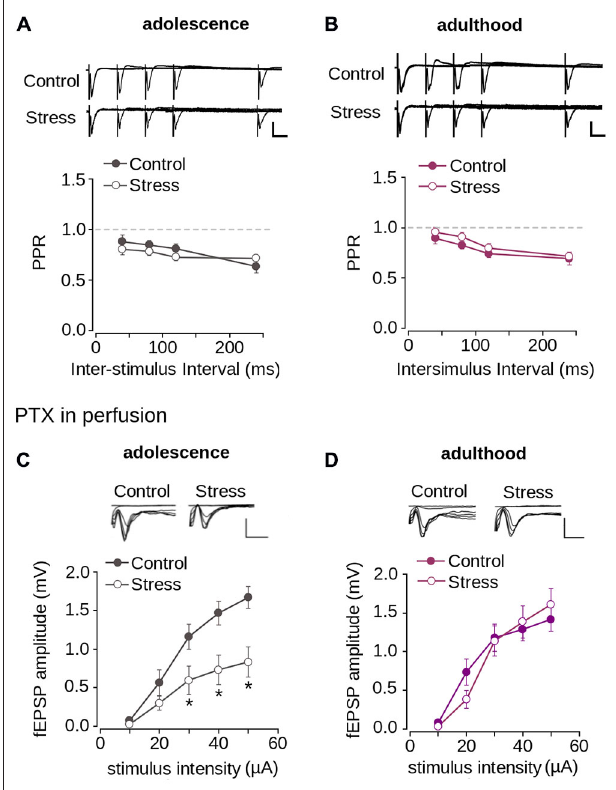
FIGURE 5 | Repeated stress did not affect paired-pulse depression and inhibitory synaptic transmission in layer 1 of mPFC. (A,B) Upper panel, representative superimposed traces from control and stress groups evoked by PPS delivered at ISI of 20, 40, 80, and 120 ms during adolescence (A) and adulthood (B) (Scale bar: 1 mV; 10 ms). Lower panel, average PPR values between control and stress groups during adolescence (A) and adulthood (B) . Data are expressed as mean ± SEM. (C,D) Upper panel, superimposed representative traces of the fEPSP evoked under different stimulus intensities in the presence of PTX 1 µ M for control and stress conditions during adolescence (C) and adulthood (D) (Scale bar: 1 mV; 5 ms). Lower panel, input-output relationship of fEPSP amplitude as function of stimulus intensity during PTX application for control and stress condition during adolescence (C) and adulthood (D) . Significant difference between control and stress: ∗ p < 0.05; Bonferroni post hoc test. Data are expressed as mean ± SEM (4 animals per group; 17-18 slices per group). ( Figure 6D ; effect of repeated stress: F ( 1,90 ) = 1.18; p = 0.28) control and stressed group animals. These findings suggest that repeated restraint stress decreases AMPA/kainate receptor- mediated glutamatergic transmission in layer 1 of the mPFC, which returns to control levels in adulthood after stress-free